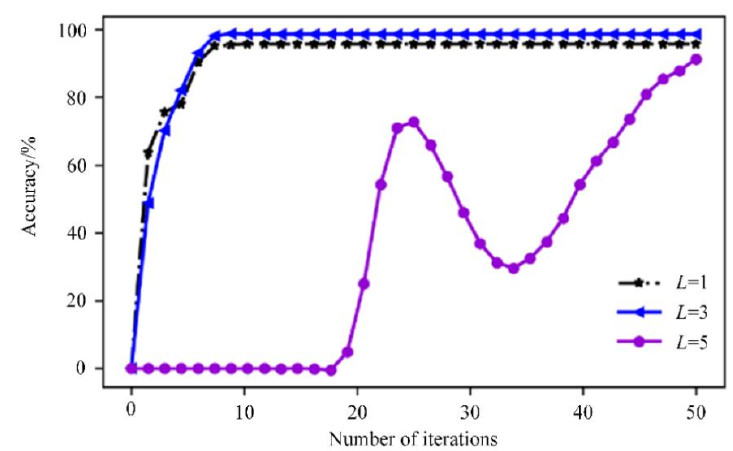
Figure 4. Change of accuracy corresponding to different number of hidden layers.